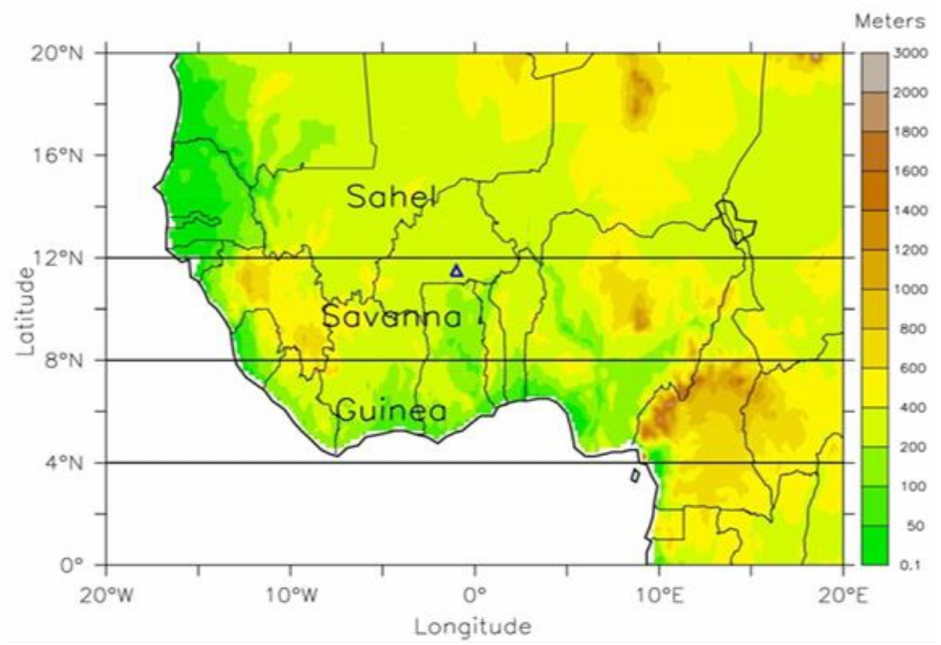
Figure 1. The study area, showing the West African topography and the three Food and Agriculture Organization (FAO) agro-ecological zones, designated as Guinea, Savannah and Sahel, respectively